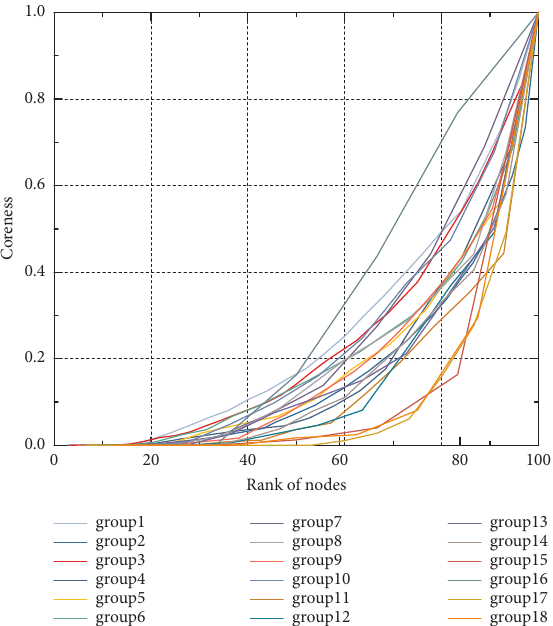
Figure 4: Coreness distribution of city groups in